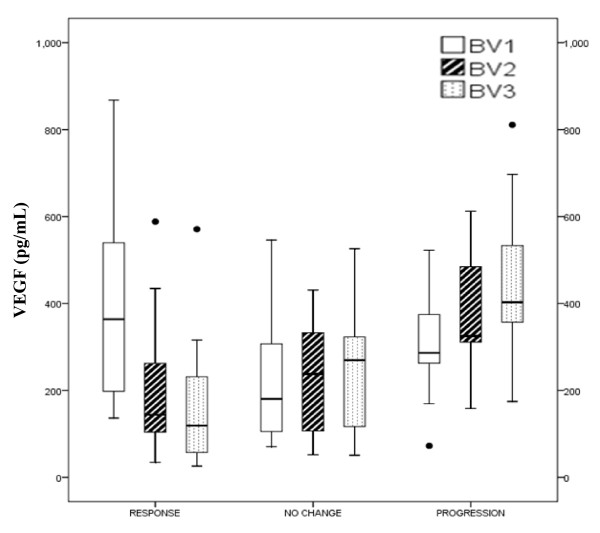
Distribution of plasma VEGF levels in various response groups. Median and interquartile range along with minimum and maximum values and outliers of the baseline values of the VEGF before start of therapy cycle 1 (pre-treatment; BV1), cycle 2 (BV2), and cycle 3 (BV3) are given.